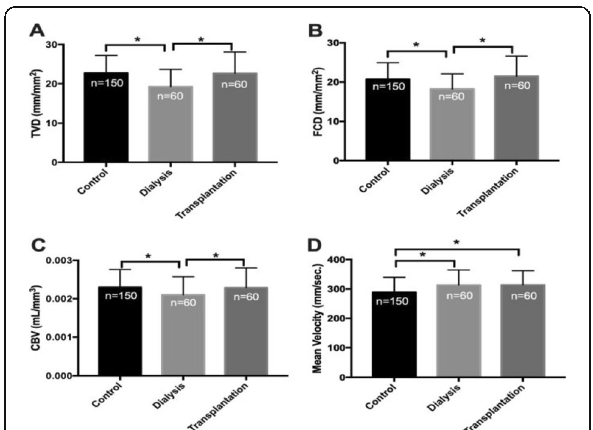
Fig. 1 (abstract 000654). See text for description